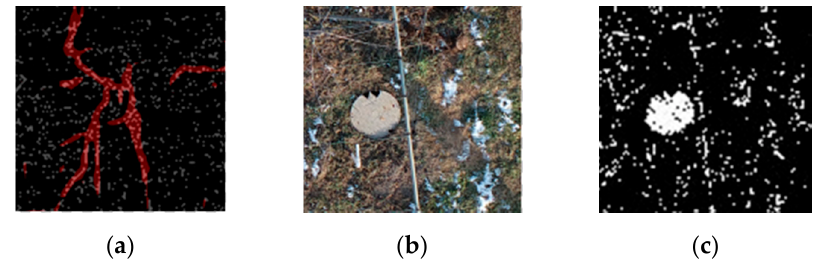
Figure 7. Comparison of the deep semantic segmentation and traditional machine learning segmentation. ( a ) The red part is the classification result of PSPnet, and the white pixels represent the classification effect of the SVM. It can be observed that the red pixels are more continuous and concentrated, and there are many surrounding white pixels. ( b ) The well covers and scaffolds in the UAV image. ( c ) The SVM mistakenly identifies irrelevant objects.